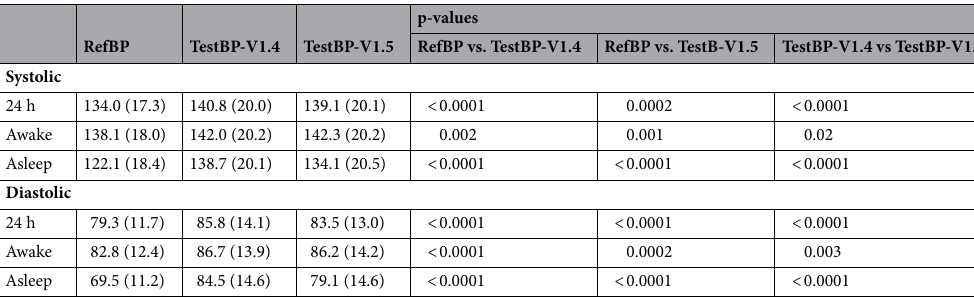
Table 2. Comparison of systolic and diastolic blood pressure measurements measured by RefBP, TestBP-V1.4 and TestBP-V1.5. Data are mean (± standard deviation), p-values are based on paired T-tests. BP blood pressure. BP expressed as mmHg.